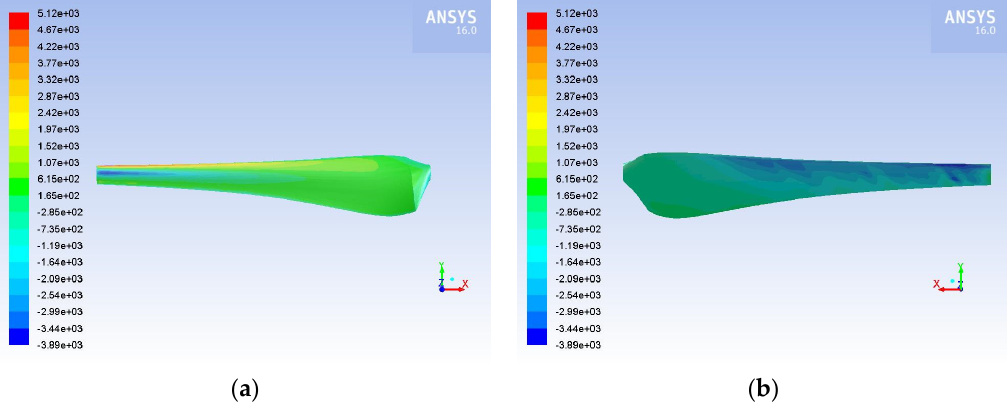
Figure 8. Contours of pressure on ( a ) the pressure; ( b ) the suction side of the blade for airflow and air velocity equal to 15 m·s − 1 .